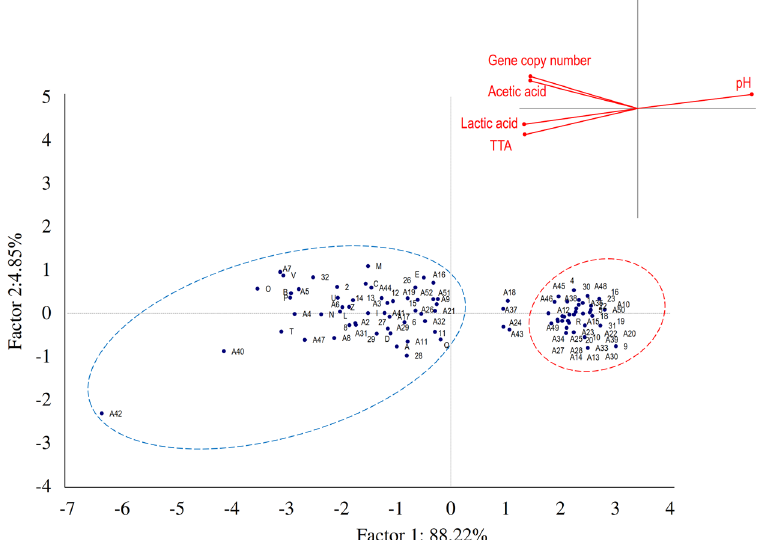
Figure 4. Principal Component Analysis. Score and loading plots of first and second principal components after principal component analysis based on values of gene copy, pH, TTA (ml NaOH 0.1 N) and concentration of lactic and acetic acids (mmol/kg) of breads collected from bakeries. Sourdough and baker’s yeast breads are delimited by blue and red line circles, respectively. Information on the commercial breads collected from bakeries is reported in Supplementary Table S6.